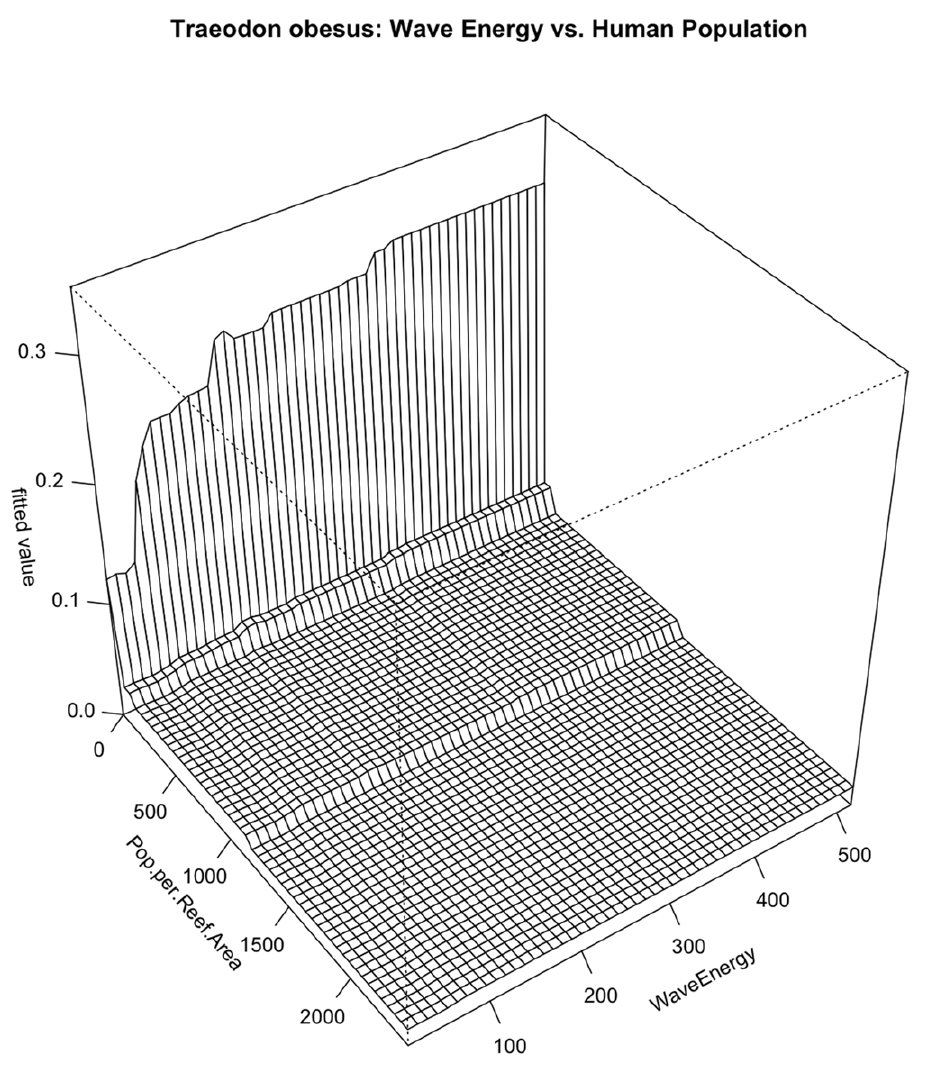
Figure 10. Pairwise interaction between human population density and wave energy with respect to occurrence of Triaenodon obesus . The effect of wave energy is influential only at the lowest human population densities and the effect of human population density is magnified in higher wave energy areas.